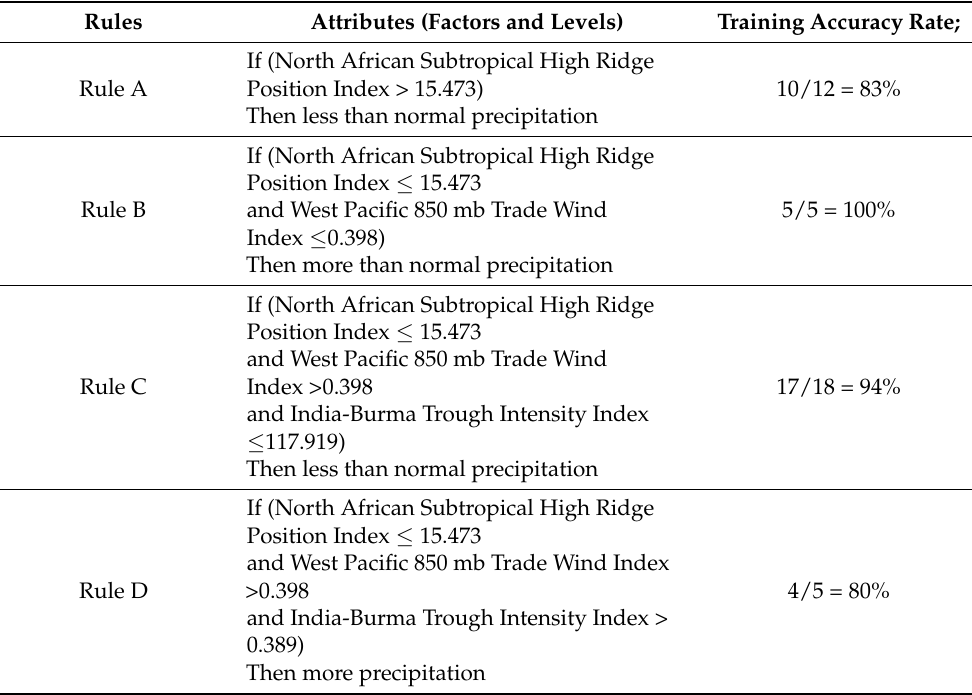
Table 2. Rule sets of summer rainfall forecast model of “Whether less (lower than 0. 5 times standard deviation)” in the cluster1 of Poyang Lake